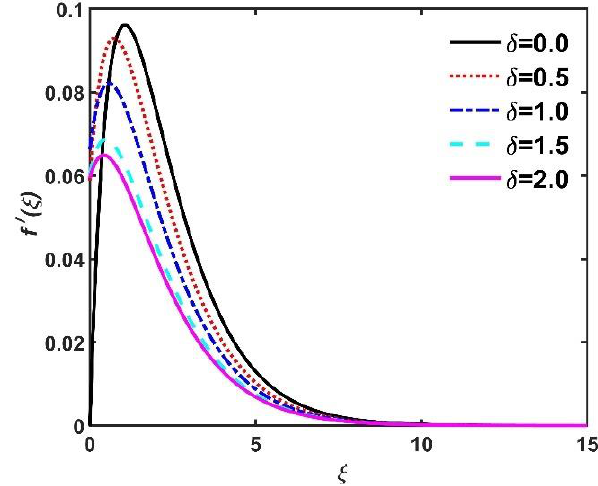
Figure 16. Impact of 𝛿 on 𝑓′(𝜉) .